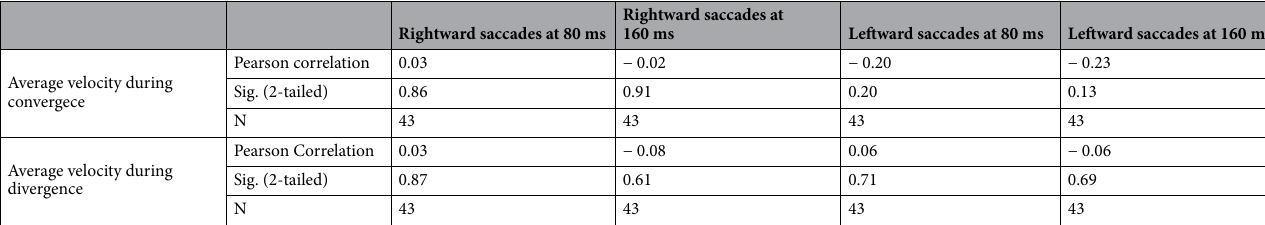
Subjective Reading Stereotest CISS Pearson correlation Sig. (2-tailed) N Pearson correlation Sig. (2-tailed) N Pearson correlation Sig. (2-tailed)